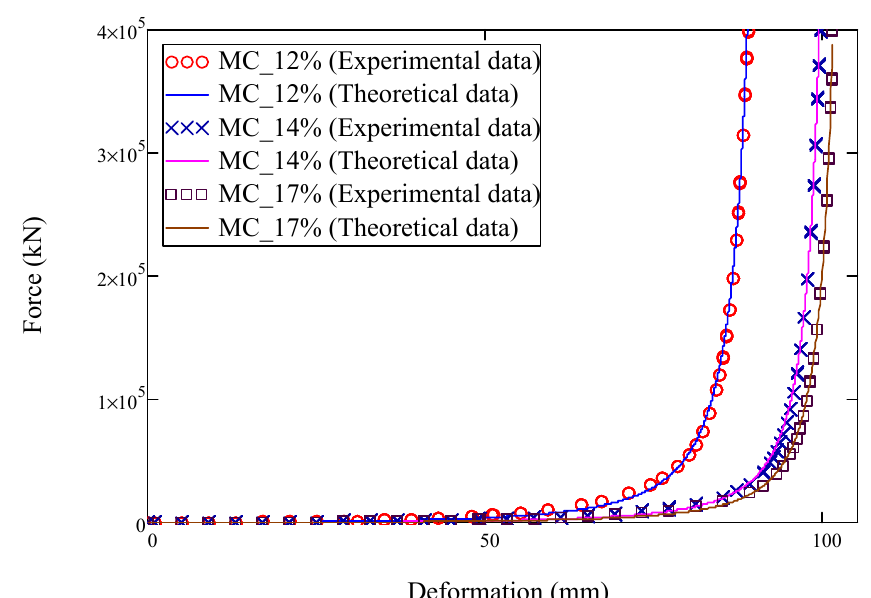
Figure 9. Force–deformation curves of ground sunflower stalk briquettes for particle sizes at a moisture content of 11.23% w.b.